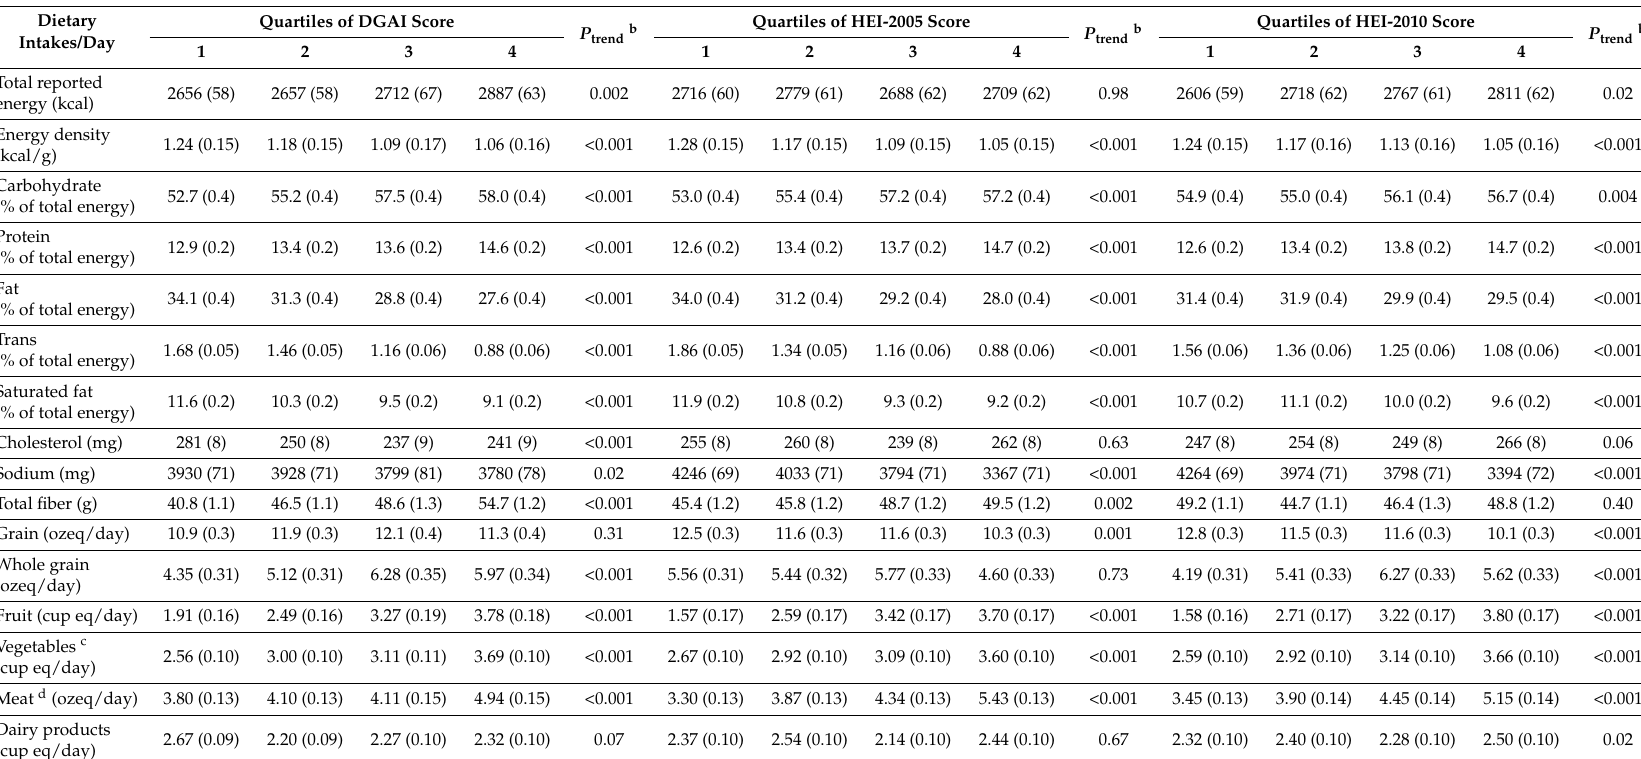
Quartiles of HEI-2010 P trend b